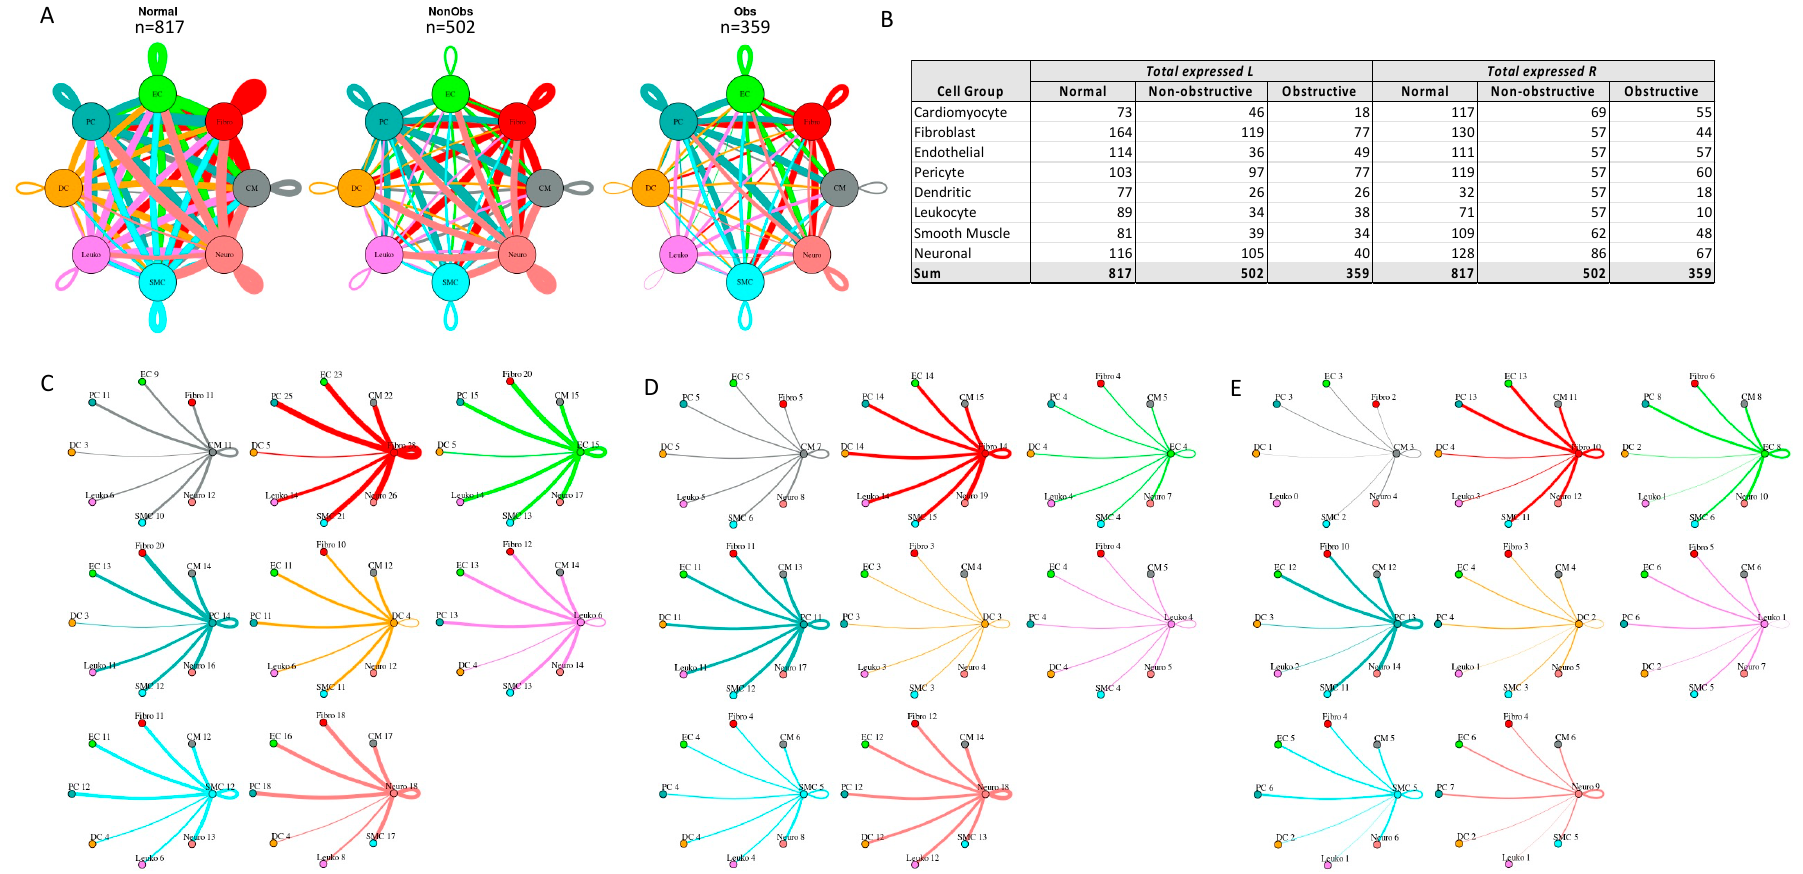
Figure 4. Intercellular communication networks in normal, nonobstructive, and obstructive HCM. ( A ) Cell–cell communication networks between cardiac cell types in normal control (left), nonobstructive (middle), and obstructive HCM (right) conditions. Line color indicates ligand broadcasting by the cell population with the same color. Lines connect to cell types which expressed cognate receptors. Line thickness is proportional to the number of uniquely expressed ligand–receptor pairs. Loops indicate communication within a cell type. ( B ) Quantity of ligands and receptors in expressed ligand–receptor pairs described by cell type and condition (normal control, nonobstructive HCM, or obstructive HCM). ( C – E ) Cell–cell communication networks broken down by cell type in normal control ( C ), nonobstructive HCM ( D ), and obstructive HCM ( E ) conditions. Figure formatting in C-E follows panel A and numbers indicate the quantity of uniquely expressed ligand–receptor pairs between the broadcasting cell type (expressing ligand) and receiving cell type (expressing receptor). The greatest potential relative reductions in intercellular communication in obstruc- tive HCM compared to nonobstructive HCM involved pathways between neurons and fibroblasts (12 total L–R pairs vs. 4 total L–R pairs, fibroblasts and leukocytes (14 L–R pairs vs. 3 L–R pairs), fibroblasts and dendritic cells (14 L–R pairs vs. 4 L–R pairs), and neurons and dendritic cells (12 L–R pairs vs. 2 L–R pairs; Figure 4C–E, Supplementary Figure S1). The reduction in neuron to fibroblast communication was due to the loss of neuronal ex- pression of several cognate ligands for the ITGB1 receptor (COL1A2, COL4A1, COL6A1, FN1, LAMA2, TGM2) and loss of RYR2 expression in fibroblasts. The reduction in fibro-